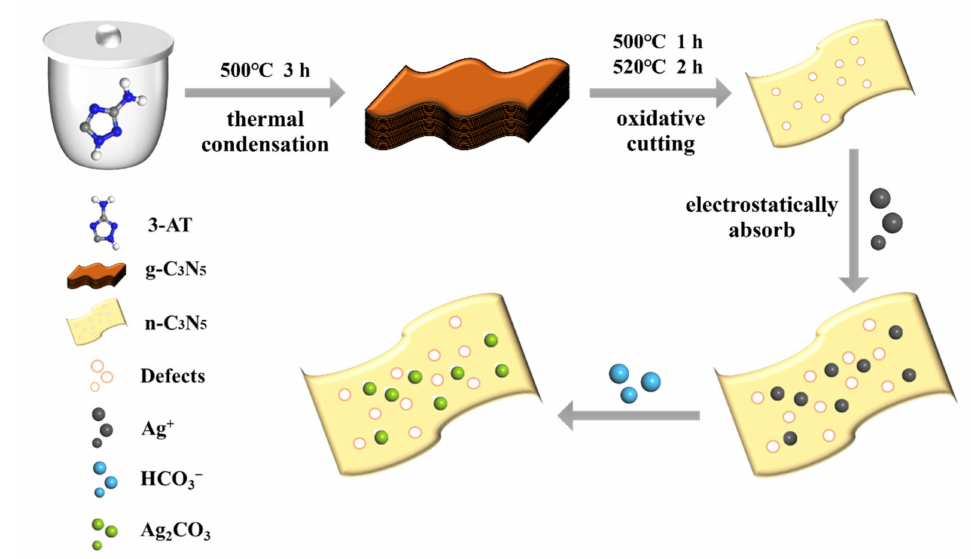
Figure 1. Illustration of the fabrication procedure of the n-C 3 N 5 /Ag 2 CO 3 (CNAC)